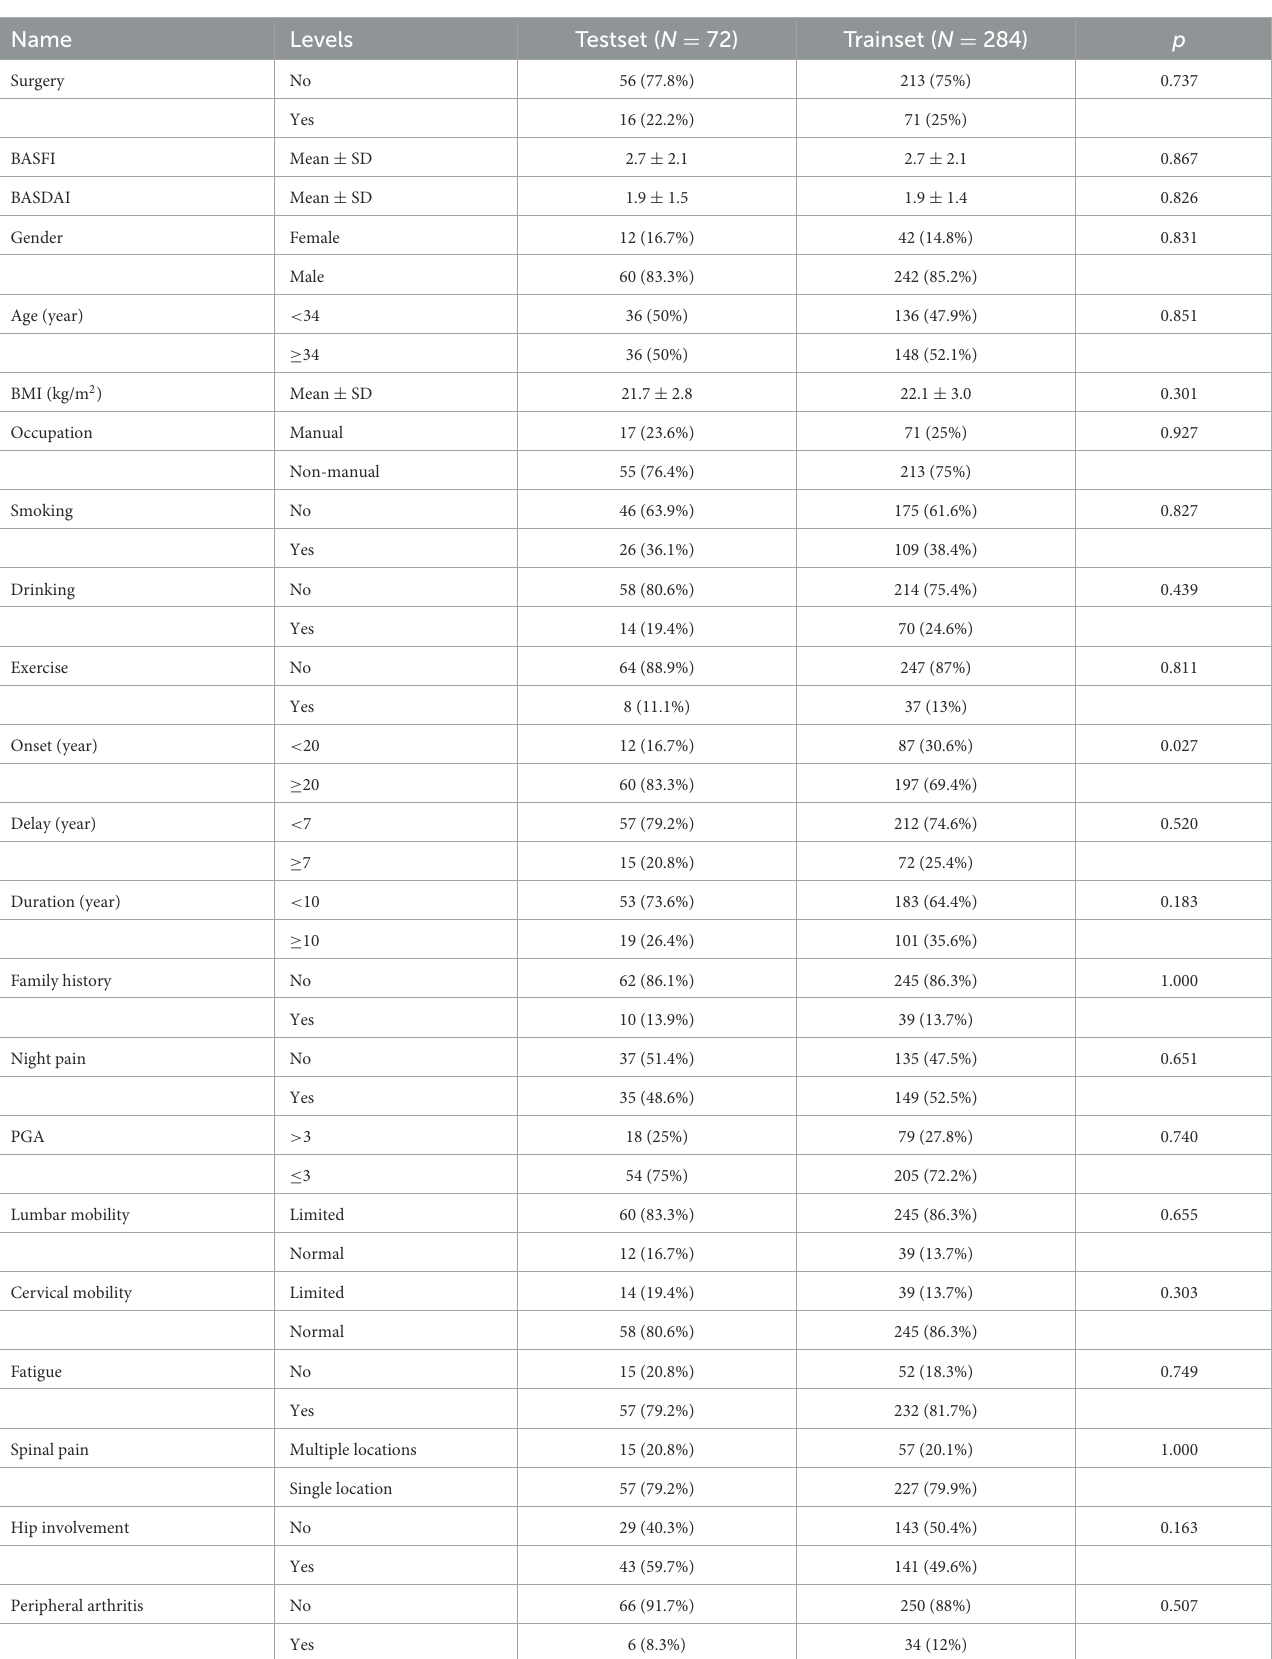
TABLE 2 Characteristics of AS patients and comparison between trainset and